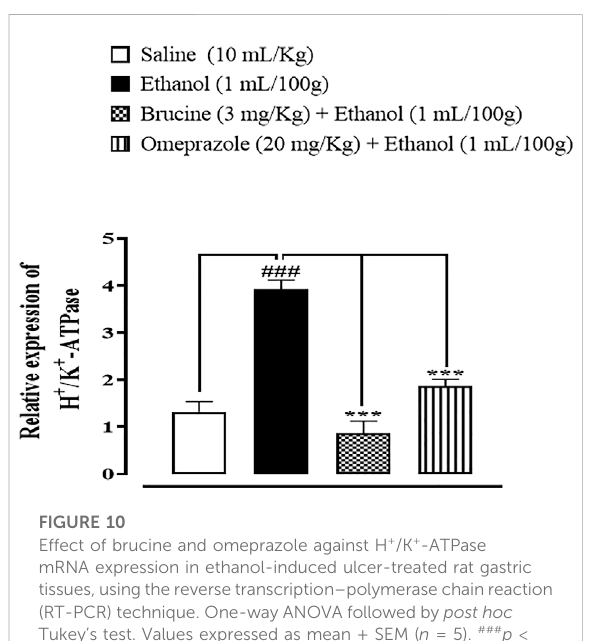
FIGURE 10 Effect of brucine and omeprazole against H + /K + -ATPase mRNA expression in ethanol-induced ulcer-treated rat gastric tissues, usingthereverse transcription – polymerase chainreaction (RT-PCR) technique. One-way ANOVA followed by post hoc Tukey ’ s test. Values expressed as mean ± SEM ( n = 5). ### p < 0.001 vs. saline group; ppp p < 0.001 vs. ethanol